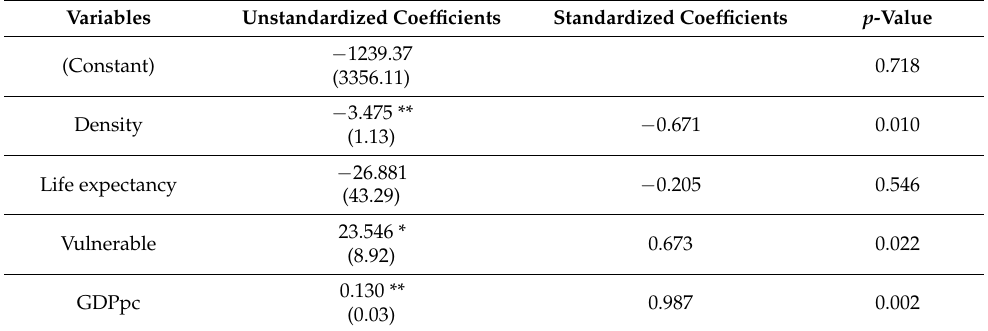
Table 3. Multiple regression model on the number of deaths from COVID-19 per million